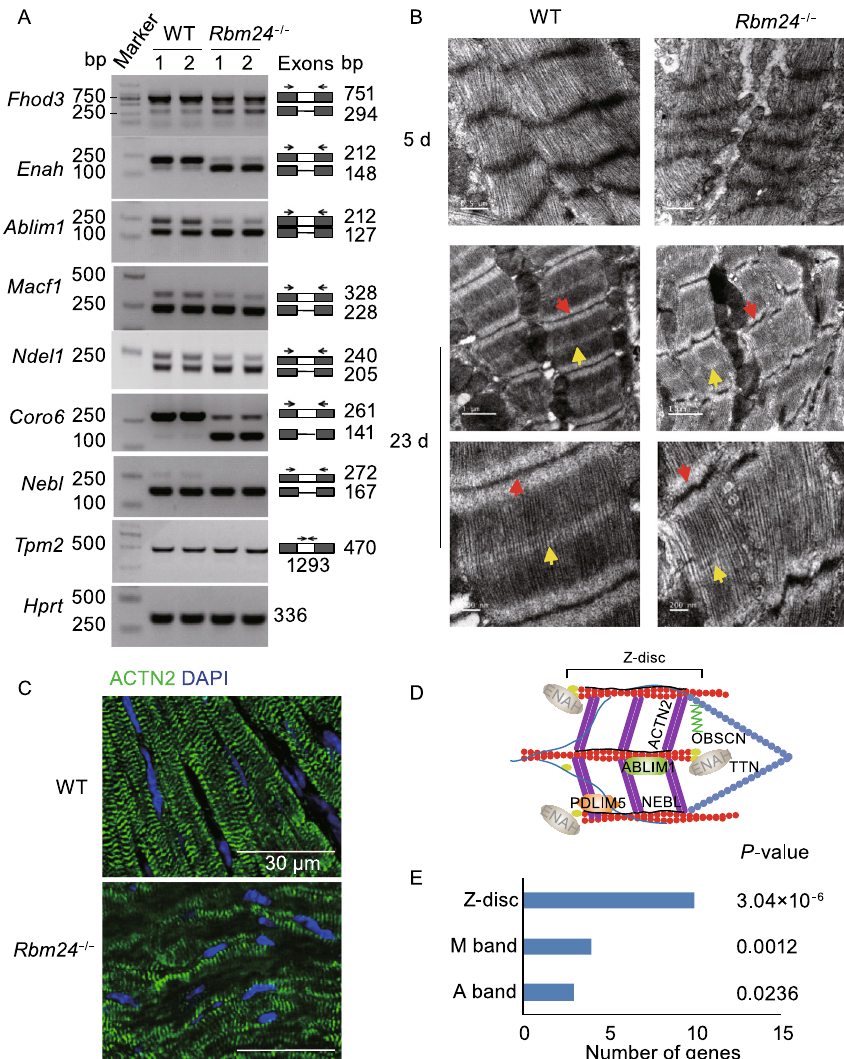
Figure 4. Misregulated sarcomeric AS events result in disruptive sarcomere structure in RBM24 knockout mouse. (A) Splicing analysis for RNAs related to sarcomere and cytoskeleton. Primer locations and expected band sizes are indicated. Hprt was used as an internal control. Data are representative of 5 – 9 independent experiments from 5 – 9 mice. (B) Representative electron microscopy analysis of sarcomere structure in Rbm24 − / − and WT mice at days 5 and 23. The red and yellow arrows indicate Z-disc and M-band, respectively. (C) Immuno fl uorescence imaging of sarcomeric protein ACTN2 (green fl uorescence) in WTand Rbm24 − / − mice. Scale bar: 30 μ m. Data are representative from 5 – 7 mice (B and C). (D) Schematic of cytoskeletal protein complexes within the cardiomyocyte Z-disc. Proteins located on the Z-disc are depicted. (E) GO analysis of sarcomere genes AS regulated by RBM24. See also Fig.